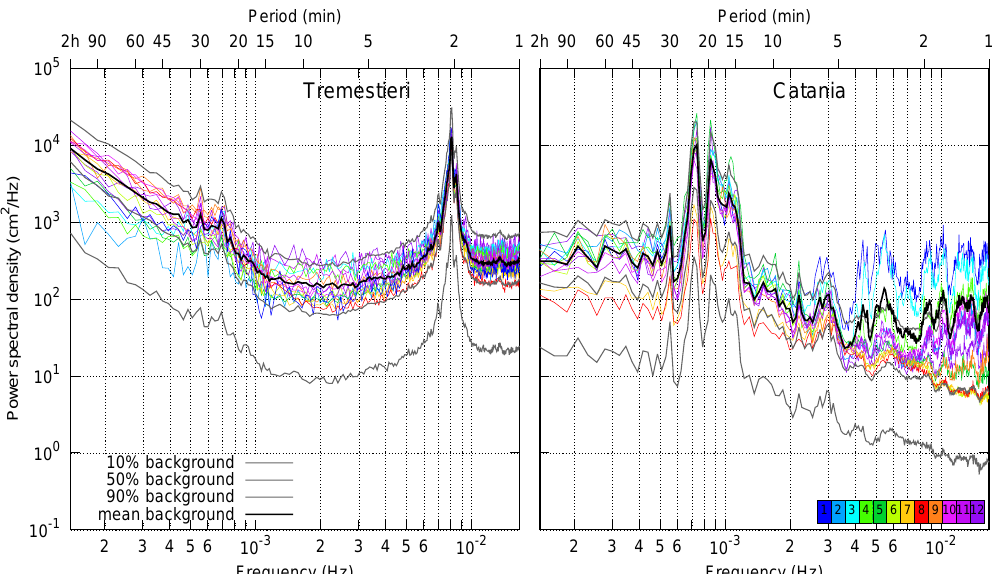
Fig. 4. Power spectral density (PSD) of Tremestieri and Catania sea-level series. The average PSD, in black, is shown together with 10, 50 and 90 percentiles, in grey. Monthly PSDs are shown with different colours (see legend) to evidence the seasonal variability. Summer months have lower spectral intensity than winter months. The Tremestieri and Catania PSD curves are quite different: a few strong short-period peaks dominate in Tremestieri, whereas Catania curves are rather wavy, with very many peaks distributed over the whole analysed range and dominating peaks between 15 and 23min. The spectra are smoothed for better